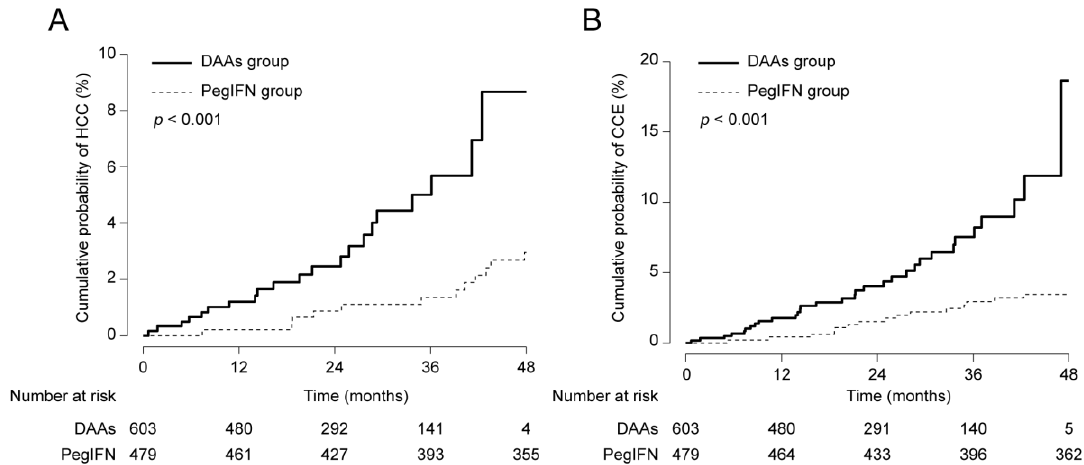
Figure 1. Cumulative probabilities of hepatocellular carcinoma (HCC) ( A ) and cirrhotic complication event (CCE) ( B ) development between the DAAs and PegIFN groups before statistical adjustment.